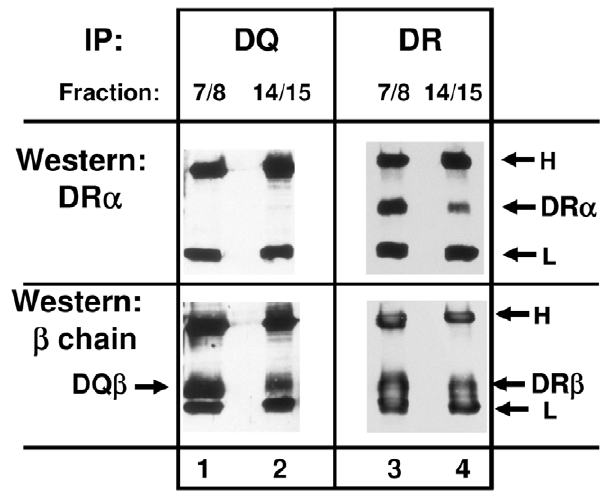
Figure 7. Isolation of DQ-Ii complexes from sucrose gradient fractions. Sucrose gradient fractions of Raji cell lysates were subjected to immunoprecipitation with mAb 1a3 against DQ and with DR mAb ISCR3. Fractions 7 and 8 or 14 and 15 were pooled and immunopre- cipitated. DQ (lanes 1 and 2) or DR (lanes 3 and 4) were isolated, and western blotted for DR a (upper panel, mAb TAL-1B5) or for DQ b (lower panel, lanes 1 and 2) and for DR b (lanes 3 and 4) with mAb LGII-612.14. The position of DR a , of DQ b or of DR b and bands corresponding to immunoglobulin heavy (H) and light (L) chains are labeled by arrows.